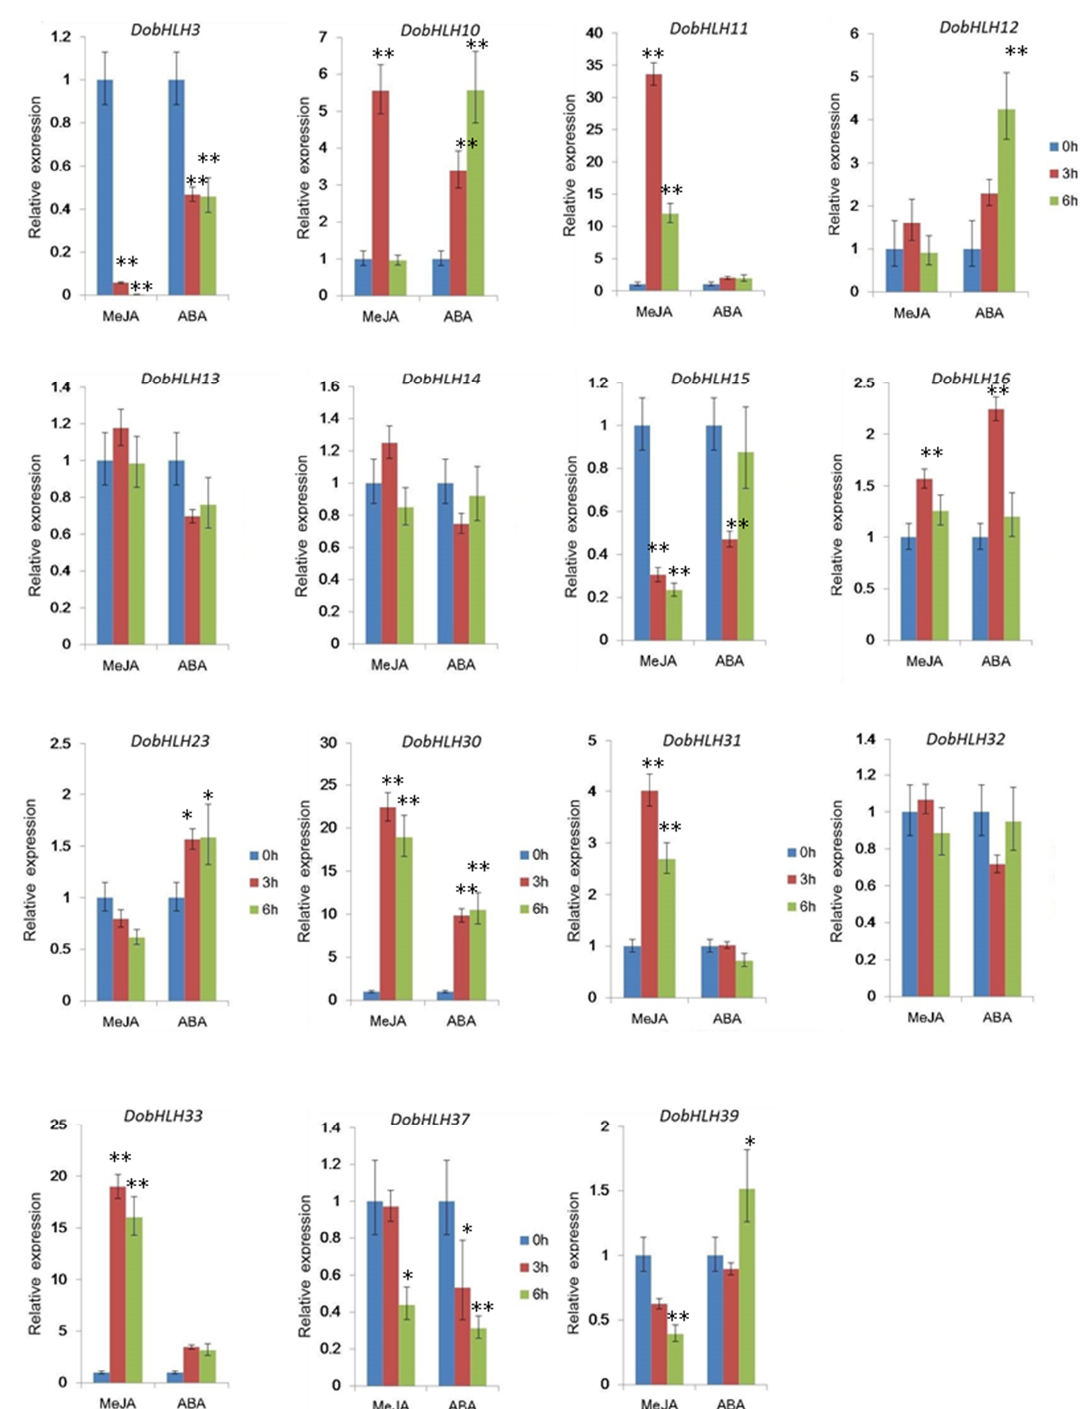
Figure 6. Expression patterns of 15 stress-related DobHLH genes under exogenous MeJA and ABA treatments by the qRT-PCR technique. After exogenous MeJA and ABA treatments in leaf tissues, the relative expression levels at 0, 3, and 6 h were tested with three biological duplicates. The relative expression levels at the beginning (0 h) were applied as the control. The bars denote the standard deviation. The star indicates the significance difference (* at p < 0.05, ** at p < 0.01) with the Student’s t-test.